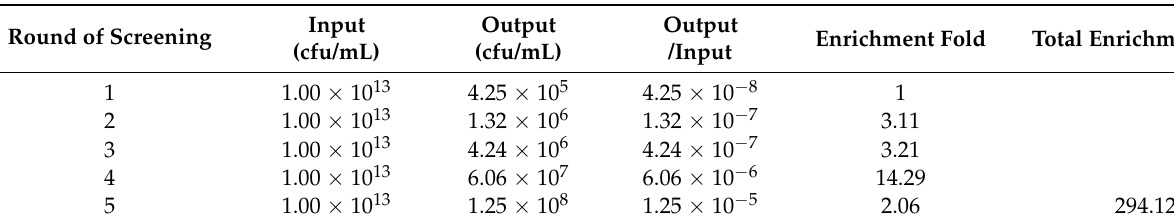
Table 2. The enrichment of scFv phage display library targeting LukD.